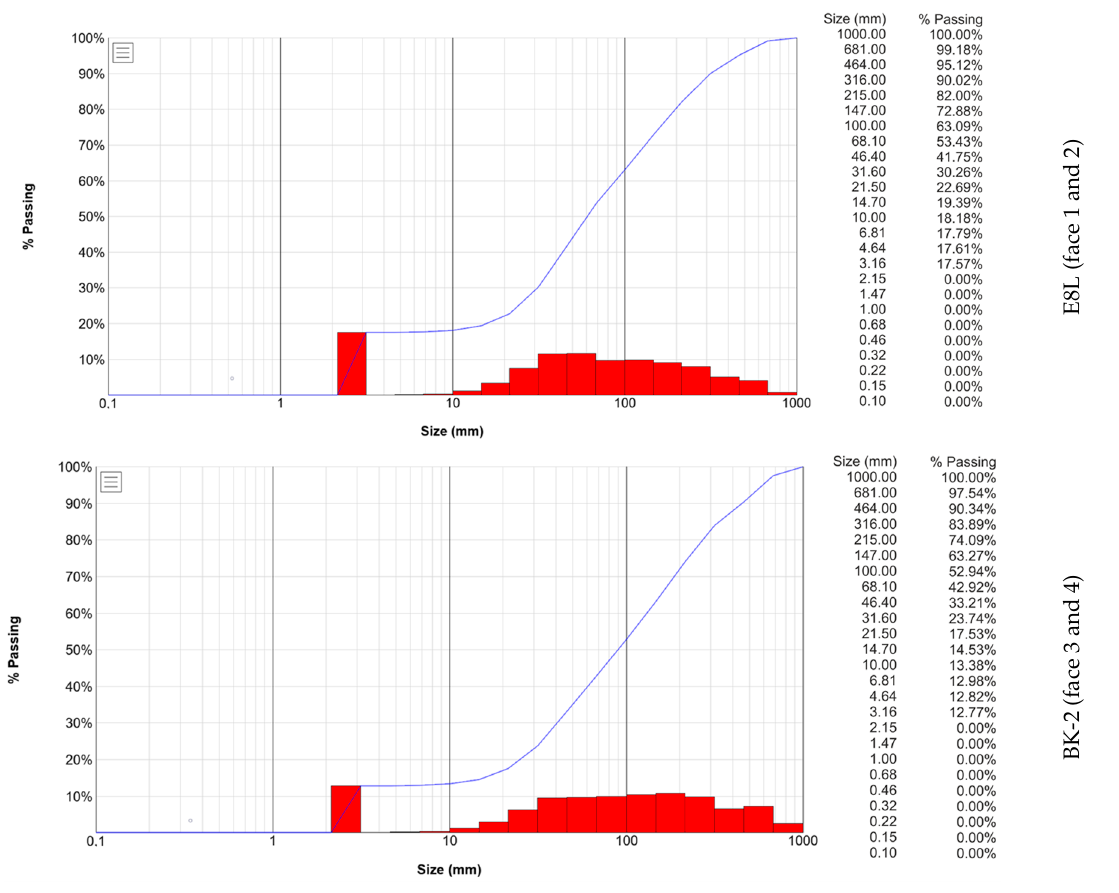
Table 4. Cumulative fragment size–distribution curves (blue) and histograms (red) for considered cases.